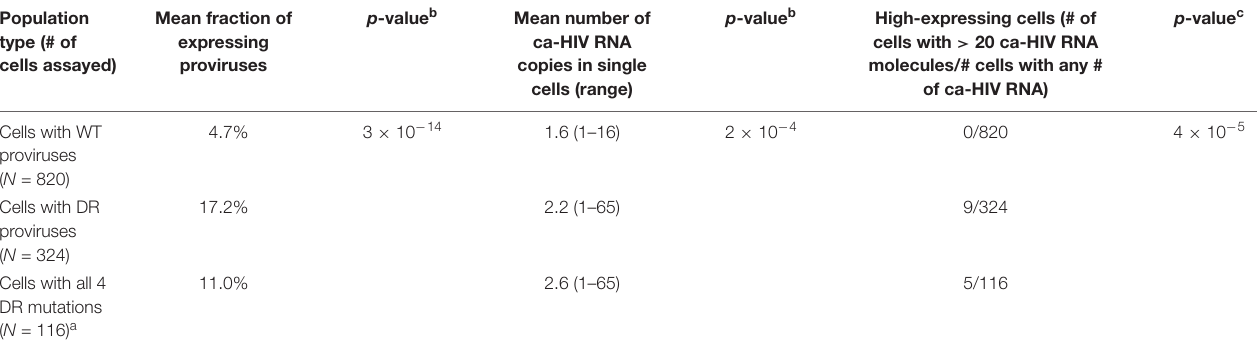
FIGURE 5 | NJ distance tree of drug-resistant variants. Plasma SGS are shown as red, open circles, PBMC proviruses with matching ca-HIV RNA are shown as orange diamonds, ca-HIV RNA in single cells are shown in different colored squares, PBMC proviruses with no ca-HIV RNA detected are open diamonds. The number of single cells that contained ca-HIV RNA is indicated by the number of different colored squares. The number of ca-HIV RNA molecules in each single cell is indicated by the number of squares of each color. One cell that contained a high level of ca-HIV RNA was detected (bright pink squares) and the sequence of this ca-HIV RNA matched the sequence of the most prevalent variant in the plasma and the sequence of the Drug Resistant Outgrowth-1 variant. Only RNA sequences identical to DR proviral DNA sequences are shown. TABLE 2 | Mean fraction of infected cells containing ca-HIV RNA and levels of ca-HIV RNA in single cells: wildtype versus drug resistant